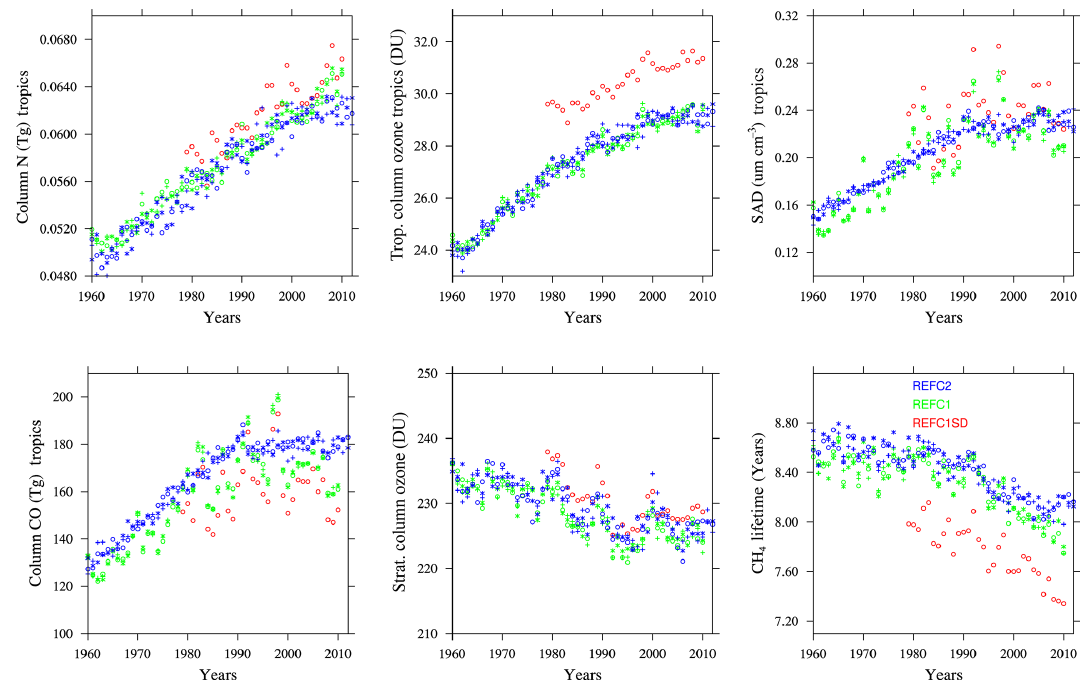
Figure 2. Time series of annually averaged column integrated tropospheric and tropical nitrogen dioxide (in Tg N), tropospheric ozone burden, and CO, in (30 ◦ S–30 ◦ N), tropical average of tropospheric surface area density, global stratospheric column ozone and tropospheric methane